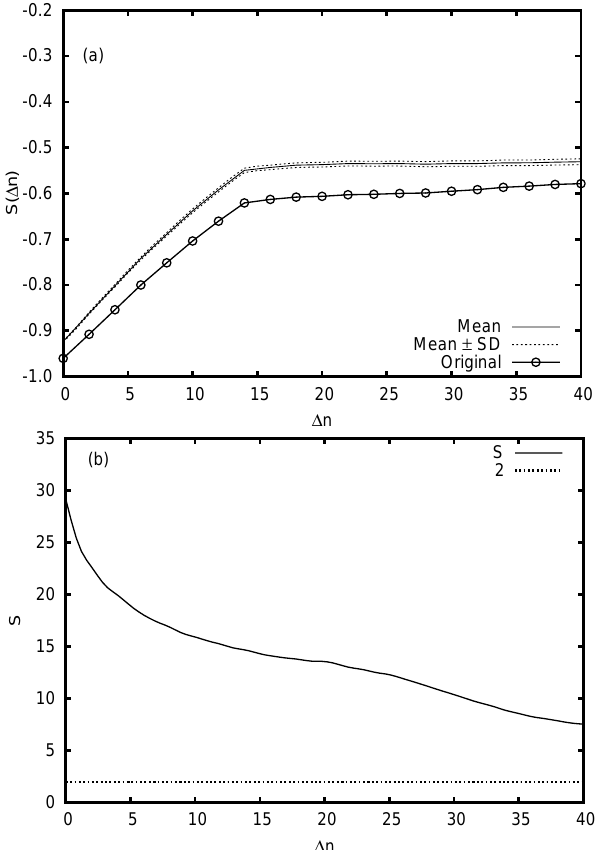
Fig. 14. (a) The mean values of S(1n) of the surrogates with stan- dard deviation. (b) Plot of the significance of difference S versus 1n .